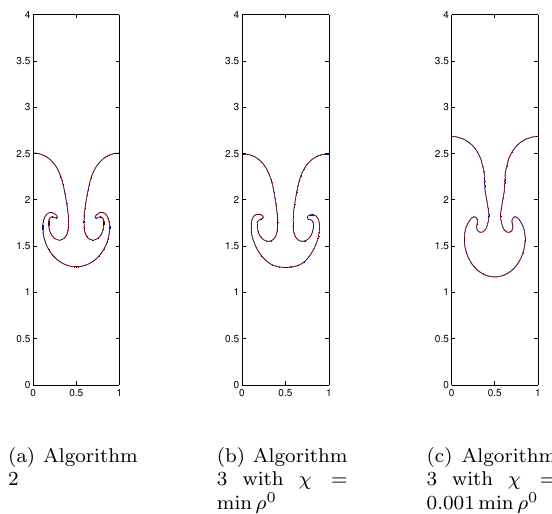
Figure 5. Re = 3000, the interface of Problem 2 at dimensionless times 1 . 75 simulated by different schemes, h = 1 /